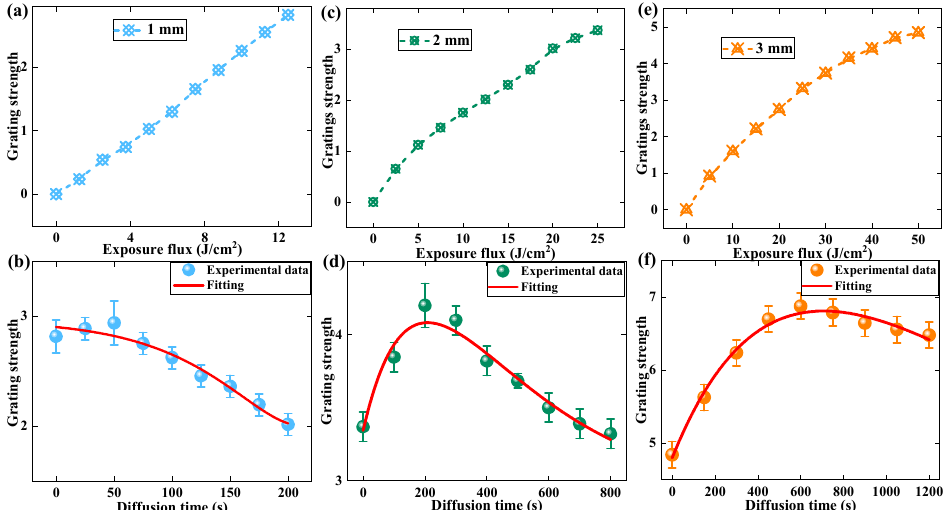
Figure 7. The evolution of grating strength during the pre-exposure and dark diffusion process: ( a , b ) 1 mm, ( c , d ) 2 mm, ( e , f ) 3 mm.